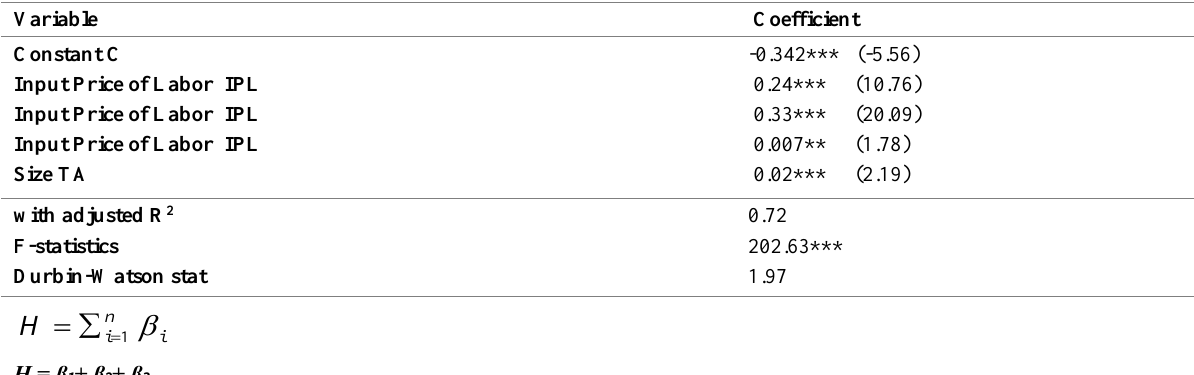
Table 3: Regression Results-Equation